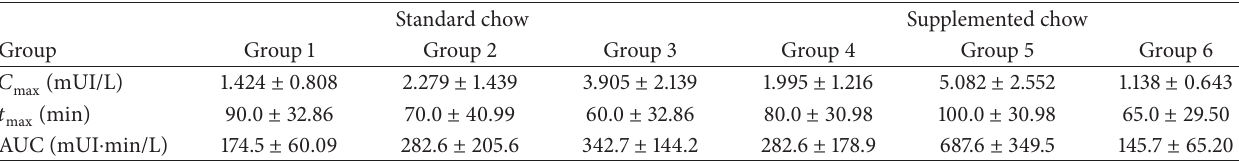
Table 2: Pharmacokinetic parameters obtained for insulin after the administration of an oral 3 g glucose load in the 6 groups after study. Group 1: control standard; group 2: oral metformin; group 3: oral metformin with Plantago ovata husk; group 4: control supplemented;